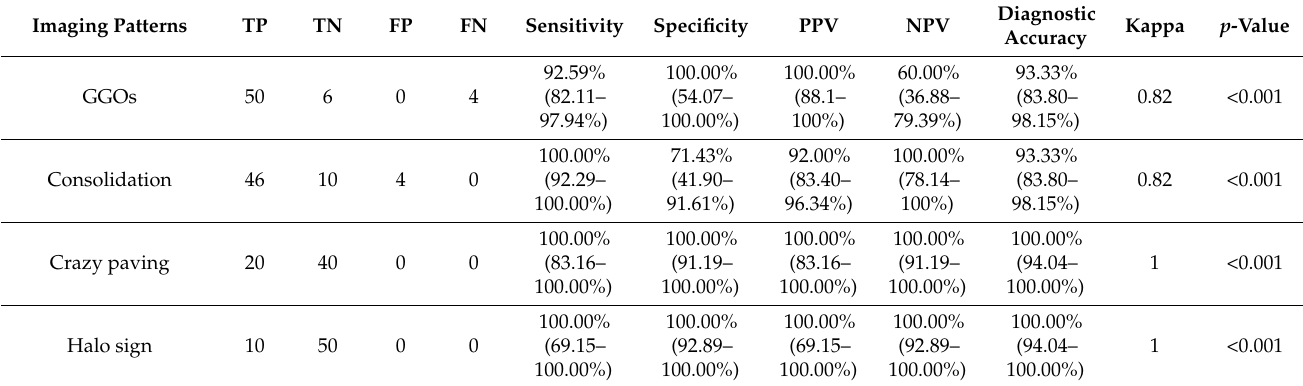
Table 4. The performance of ULDCT in detecting the imaging patterns of COVID-19 pneumonia (with SDCT as the reference standard).